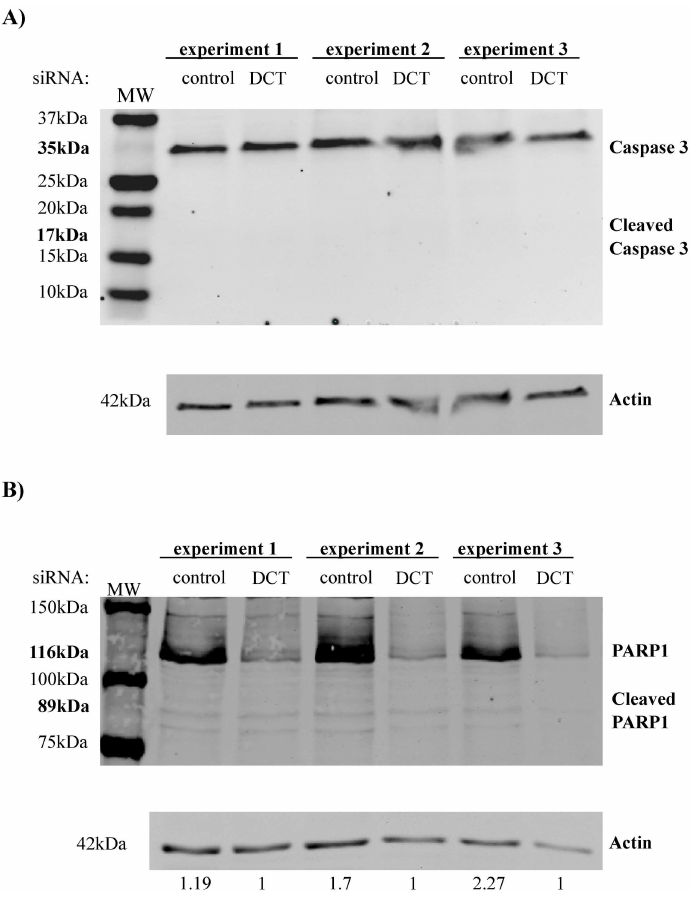
Fig 8. Apoptosis markersare not present in control and DCT knockdown cells. Cell lysates from control and DCT knockdown cells were harvestedand subjectedto western blotting on the day of the knockdown for three independent DCT knockdown experiments. For none of the samples, cleavedforms of caspase 3 or PARP1 was detectable.(A) Western blot for Caspase3, cleaved caspase 3 and actin (loadingcontrol). (B) Western blot for PARP1, cleaved PARP 1 and actin